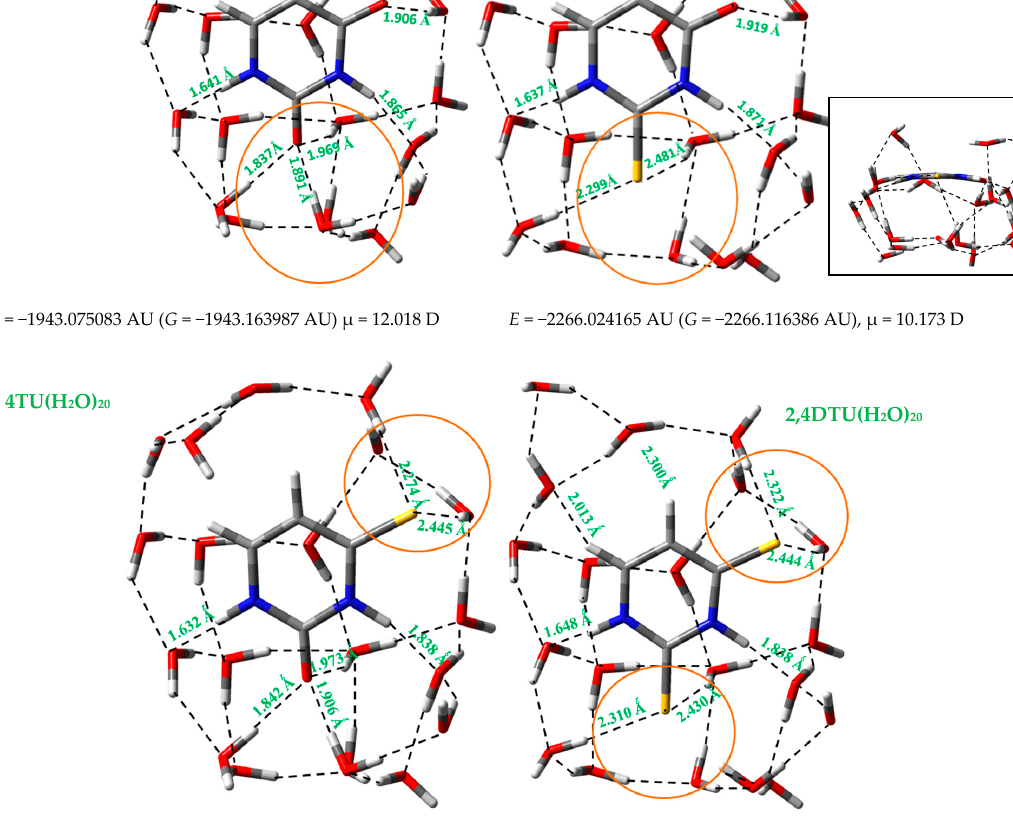
Figure 2. Comparison of the hydrated clusters with 20 water molecules corresponding to uracil, 2-thiouracil, 4-thiouracil and 2,4-dithiouracil molecules optimized at the B3LYP / 6-31G(d,p) level. The main di ff erences are indicated by a circle. The total electronic energy + ZPE (Zero point energy) ( E ) and Gibbs energy ( G ) are in AU, and the dipole moment (µ) in Debye. Due to the lower attraction of sulphur, the water molecules are stronger H-bonded to the oxygen